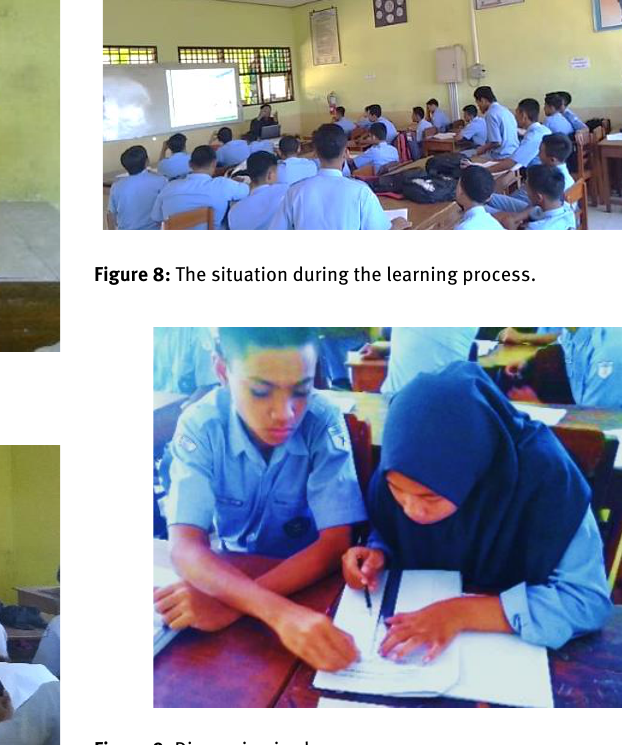
Figure 9: Discussion in class.